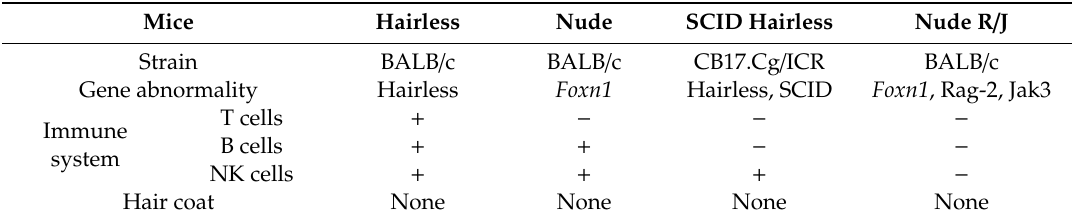
Table 3. Comparison of hairless mice.